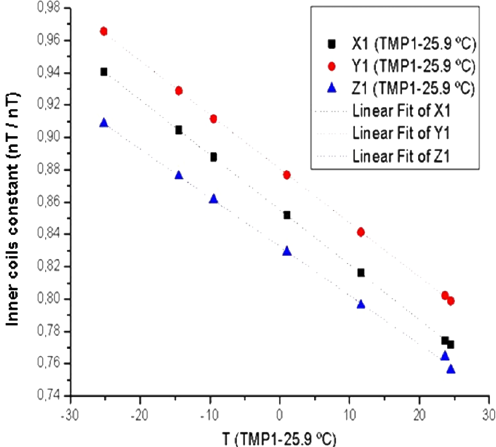
Figure 11. Linear fits of gain as a function of corrected temperature (TMP1-Tref).